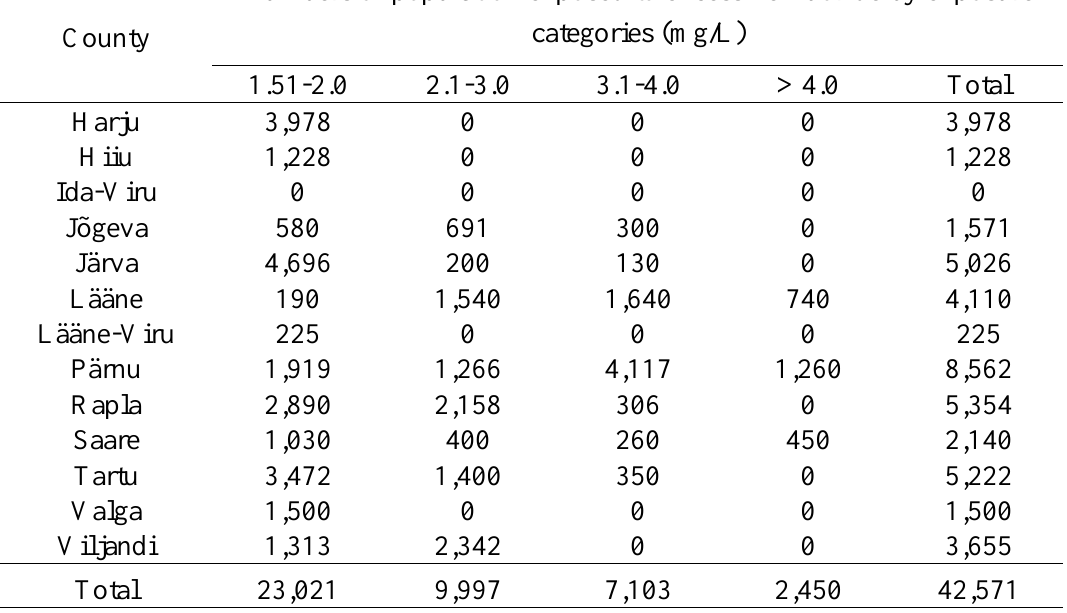
Table 2. Population exposure to excessive fluoride in drinking water by